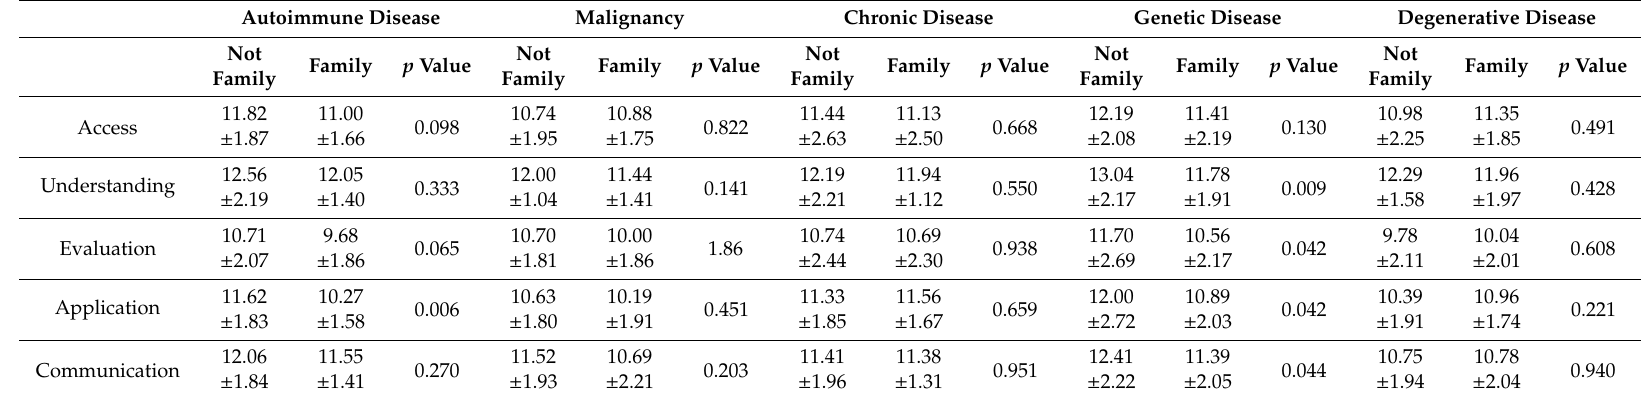
Table 3. The association between participation (patient or family) and all dimensions of MMHLQ divided by types of PSGs. Autoimmune Disease